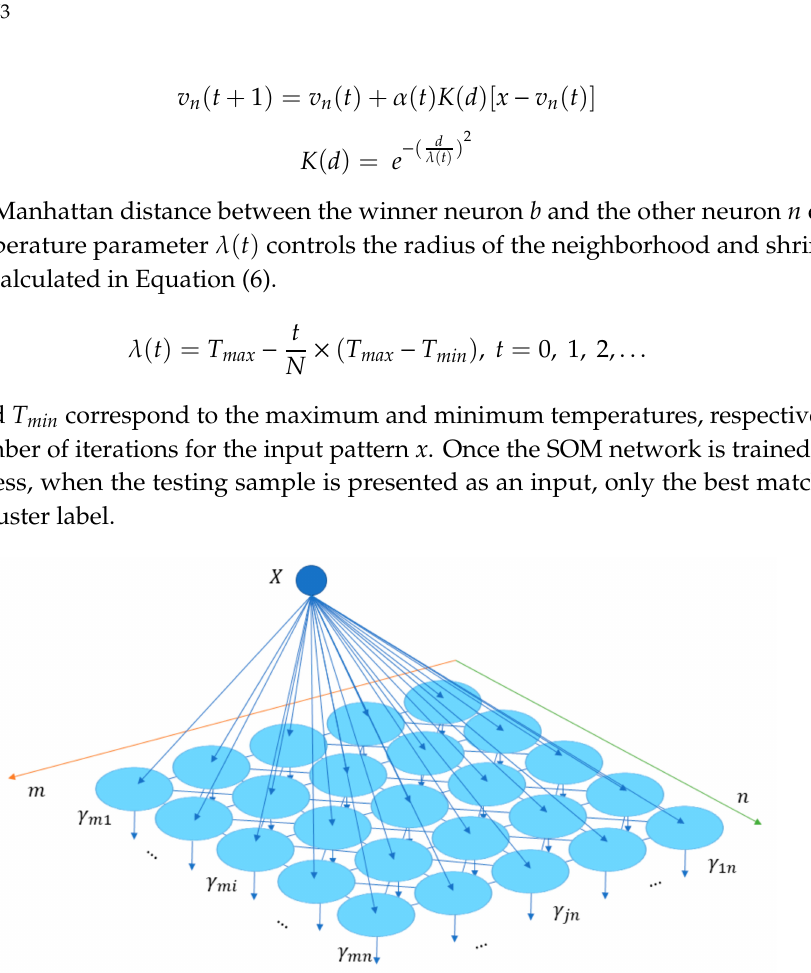
Figure 3. The internal structure of the SOM. A feature vector X is provided to the SOM map with the size of m × n, and the best matching unit is selected among the grid neurons γ ij ( 1 ≤ i ≤ m and 1 ≤ j ≤ n ) . Afterward, the weight vectors of the winner unit and its neighboring units are updated. When the learning process is completed, each sample is assigned to its nearest node